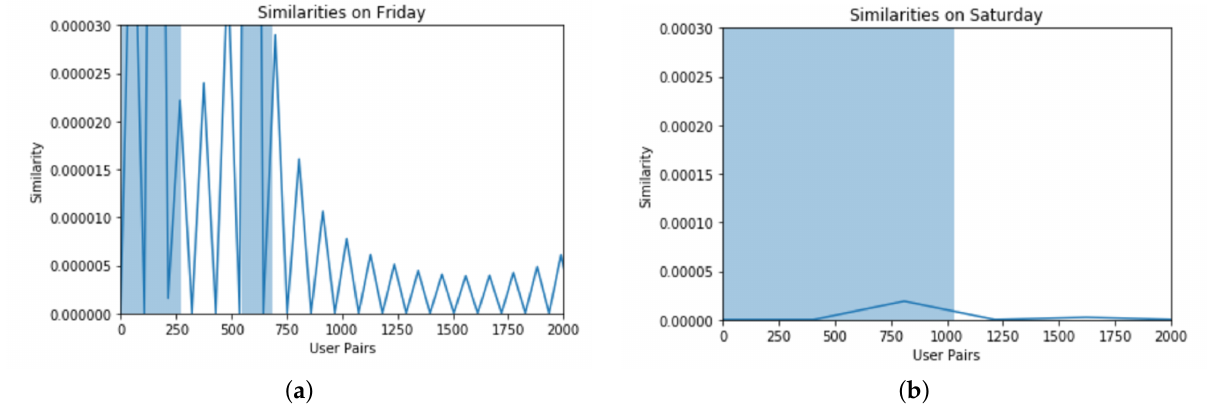
Figure 3. Similarity analysis during different days, ( a ) On Friday, and ( b ) On Saturday. Similarity shows that these users are found on the same location during the same time